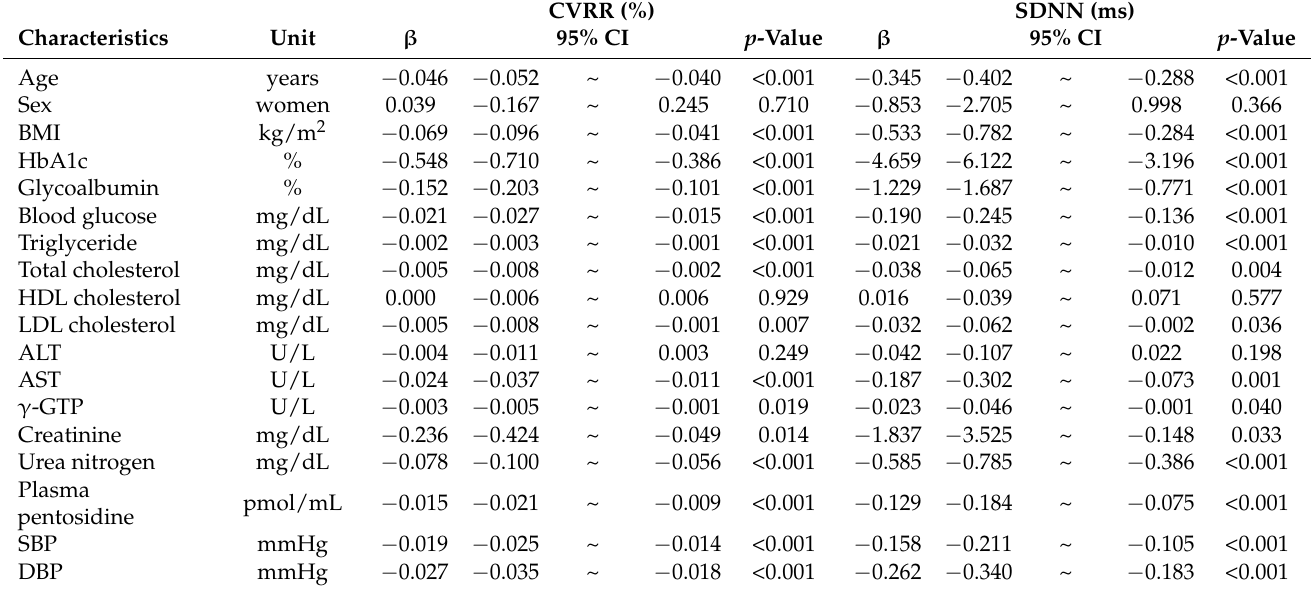
Table 2. Univariate analysis of association with CVRR and SDNN.